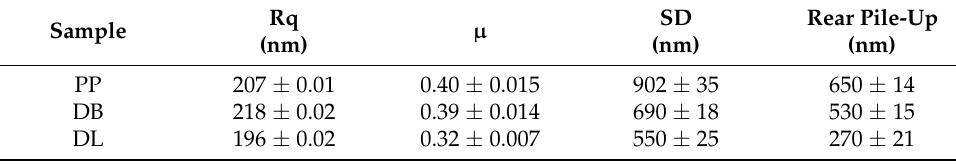
Table 7. The RMS roughness (Rq), the coefficient of friction ( µ ), the scratch depth (SD) and the scratch pile-up measured for PP and PP hybrid composites.